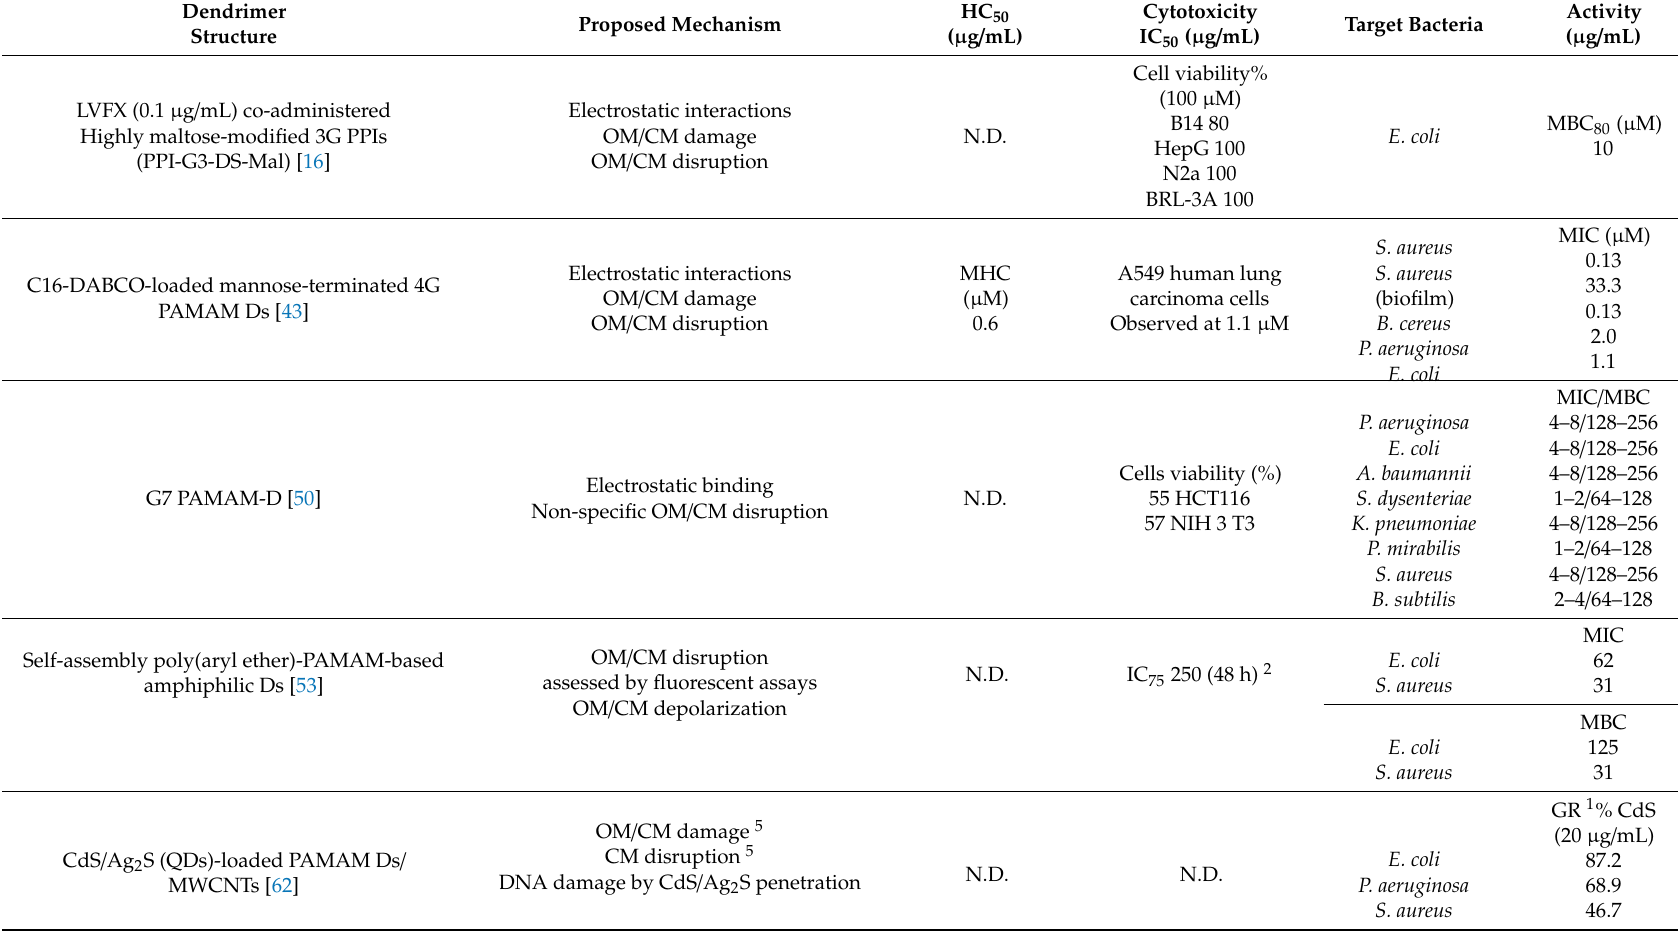
Table 5. Most representative positively charged antimicrobial PPI- and PAMAM Ds developed in the years 2010–2020 and antibacterial activity of the most e ff ective among the synthetized